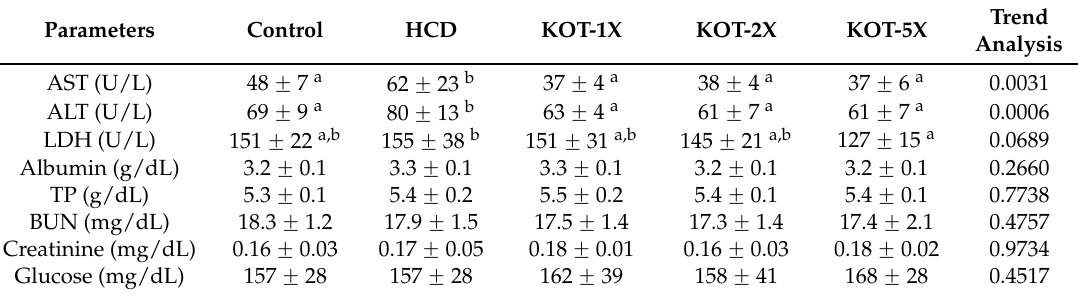
Table 4. Biochemical analysis of KOT treatment groups at the end of experiment.